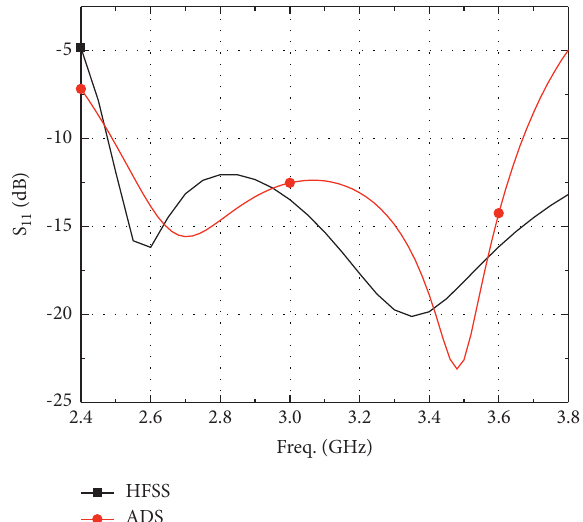
Figure 4: The simulated results of the equivalent circuit by ADS and full-wave calculation by HFSS.